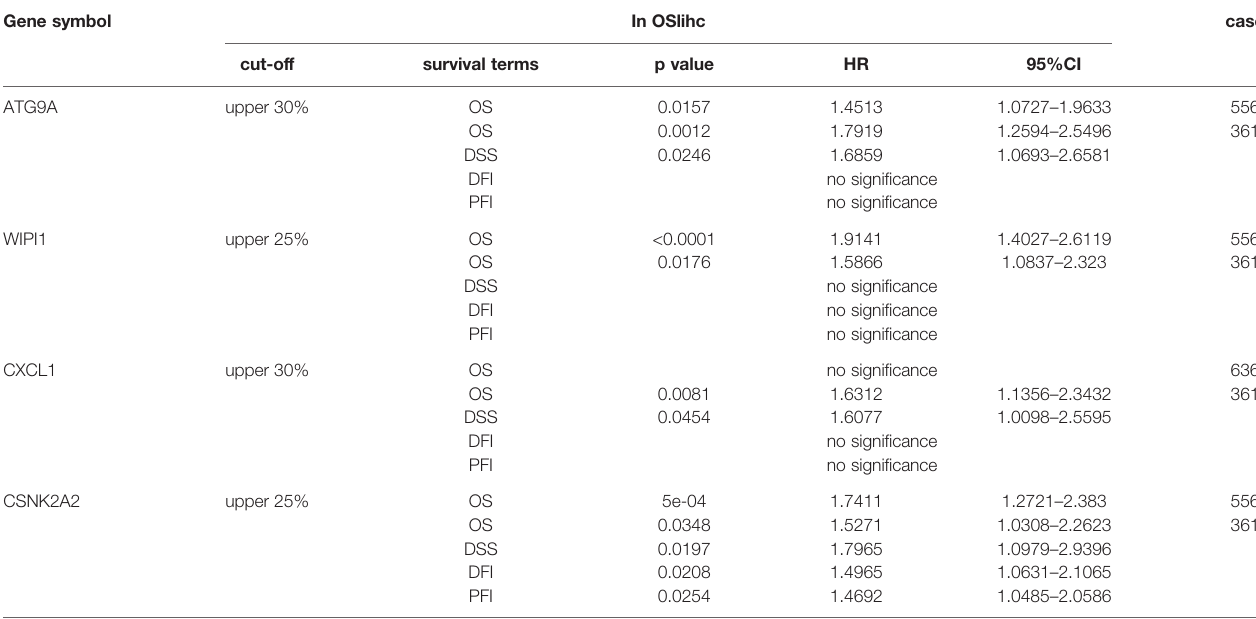
TABLE 3 | Evaluation of novel potential prognostic biomarkers for LIHC in OSlihc. Gene symbol In OSlihc